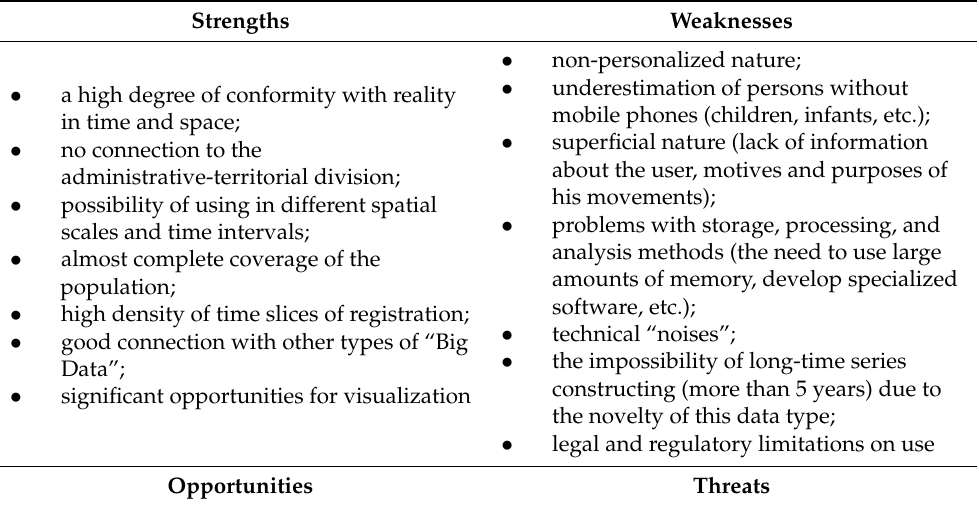
Table 1. SWOT analysis of mobile operators’ data in relation to geographical